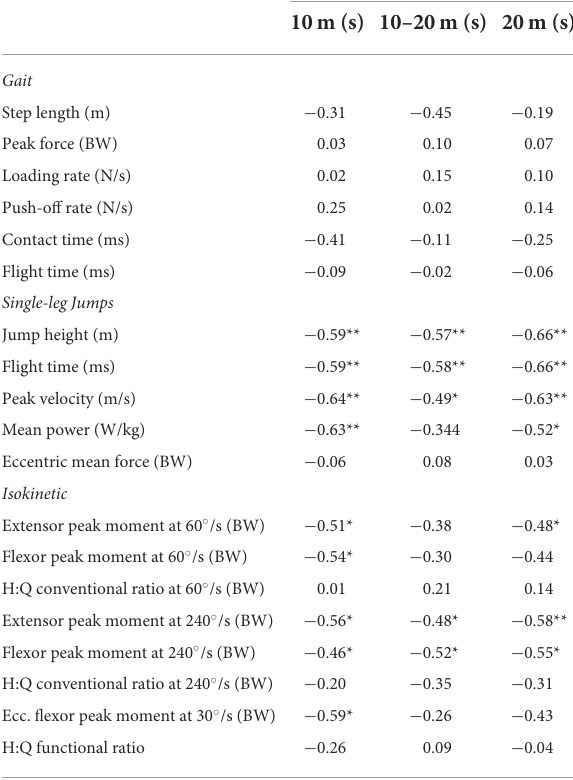
TABLE 3 Pearson’s correlations ( r ) between the CoD split times and the variables in the gait, single-leg jump and isokinetic assessments.